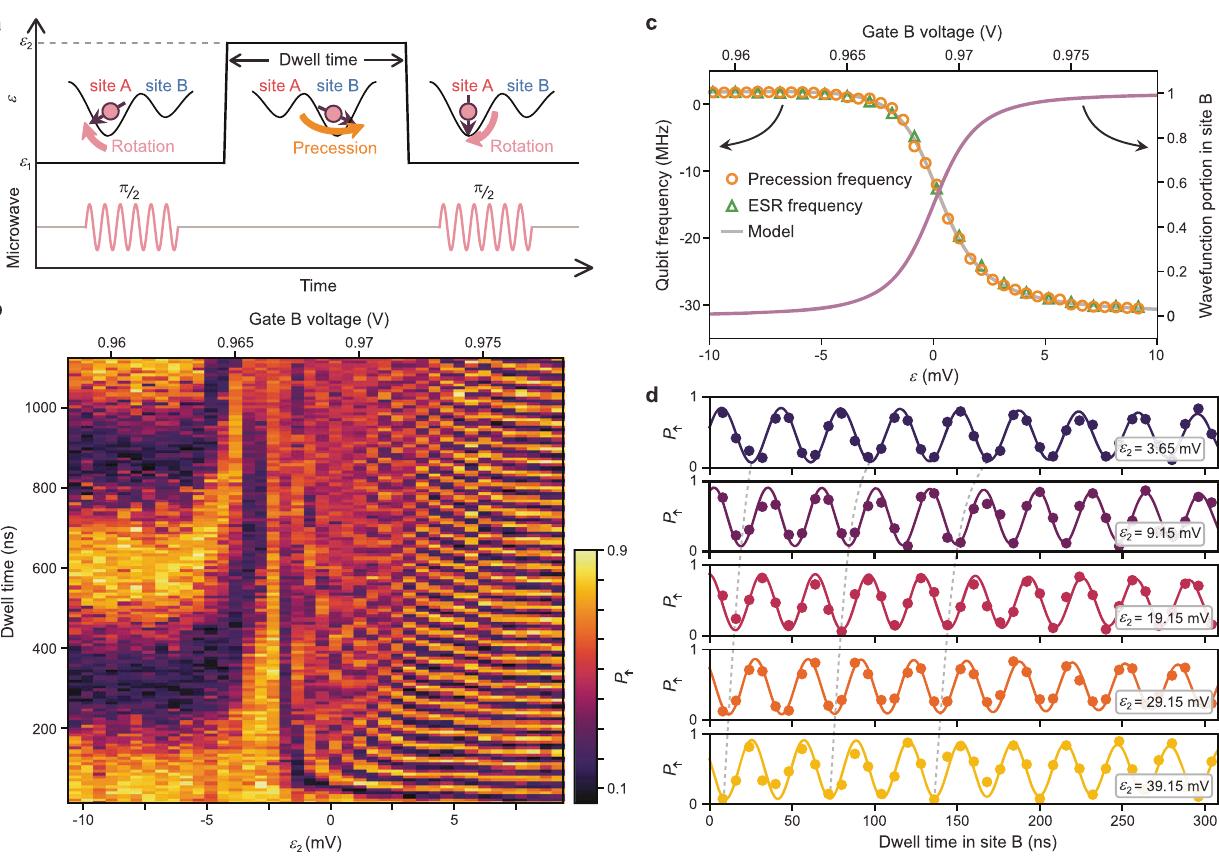
Fig. 2 Coherent tunneling spectroscopy. a Pulse schematic used for the tunneling spectroscopy. The spin, prepared in # at site A, is fi rst rotated to an equatorial state and then accumulates a phase during the interdot detuning pulse for a dwell time t dwell , until a second π /2 pulse projects the phase to the polarization ( " or # ). b Tunneling spectroscopy performed across the interdot transition. The detuning value prior to the pulse, ε 1 , is − 50.85 mV. The continuous fringe evolution demonstrates the phase coherence during the tunneling process. The oscillation visibility is predominantly set by the state- preparation and measurement errors. c Qubit spectrum extracted from the precession frequency (orange dots) as well as from the ESR spectrum (green triangles, offset by 27.8354128 GHz). The gray curve shows a fi t to a four-level model with spin-dependent tunnel couplings. The purple solid line plots the spin- # electron wavefunction portion in site B calculated from the model (the one for the " case overlaps with this). d Shuttling process as a phase gate. Rapid, 30 MHz phase rotations in the site B region are observed down to t dwell ¼ 8 ns. Dashed lines are guides to the eye for the fi rst, third and fi fth oscillation